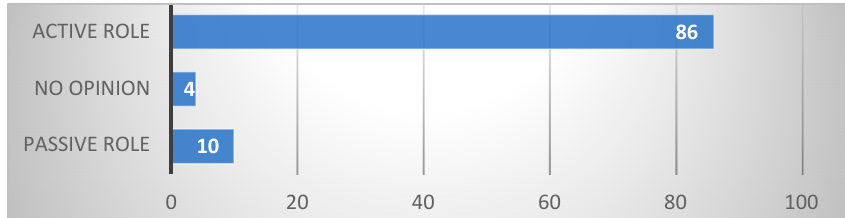
Figure 3. The respondents’ views (%) on their role in an SC. Source: own elaboration.